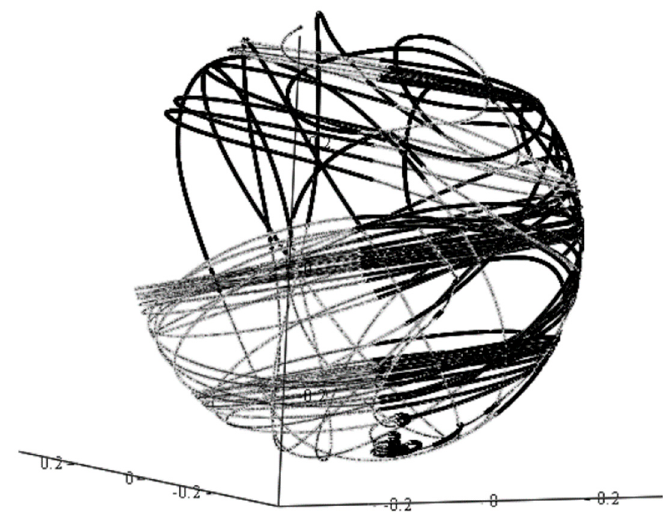
Figure 9. Trajectory of carbon atom under the influence of a magnetic field.